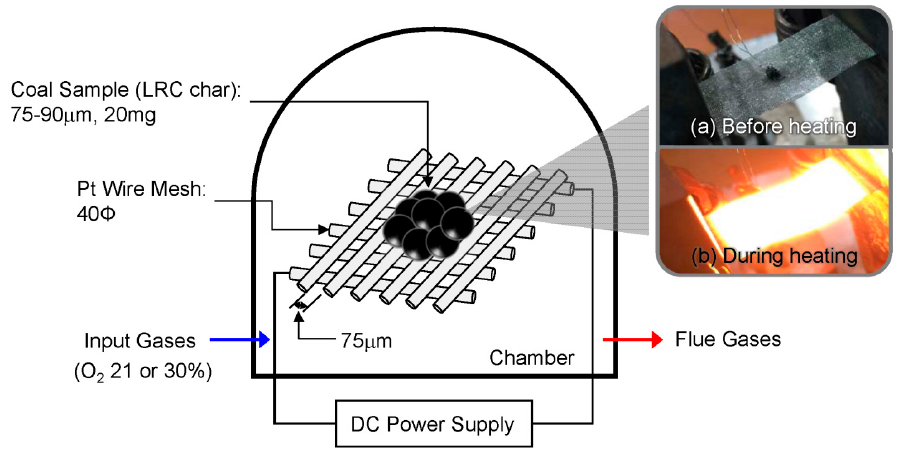
Figure 2. Schematic of the coal heating reactor. The photographs on the right show the system ( a ) before heating and ( b ) during heating.